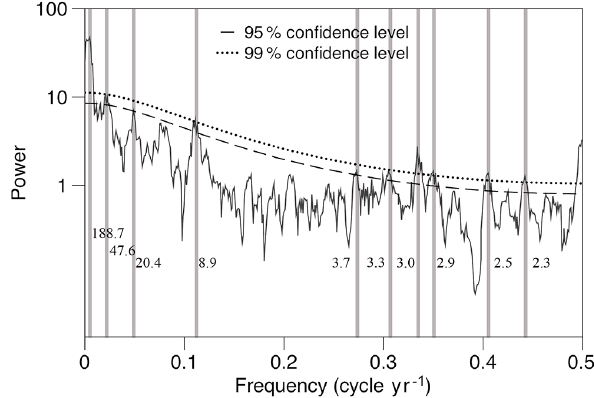
Figure 6. The MTM power spectrum of the reconstructed August– December minimum temperature (VUSr) from 1529 to